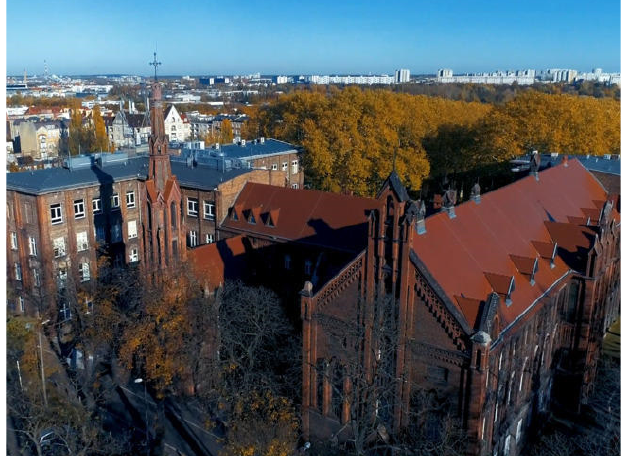
Figure 4. Orthopaedic hospital in Poznan, source: https://www.siepomaga.pl/degapoznan, access: 15 June 2022